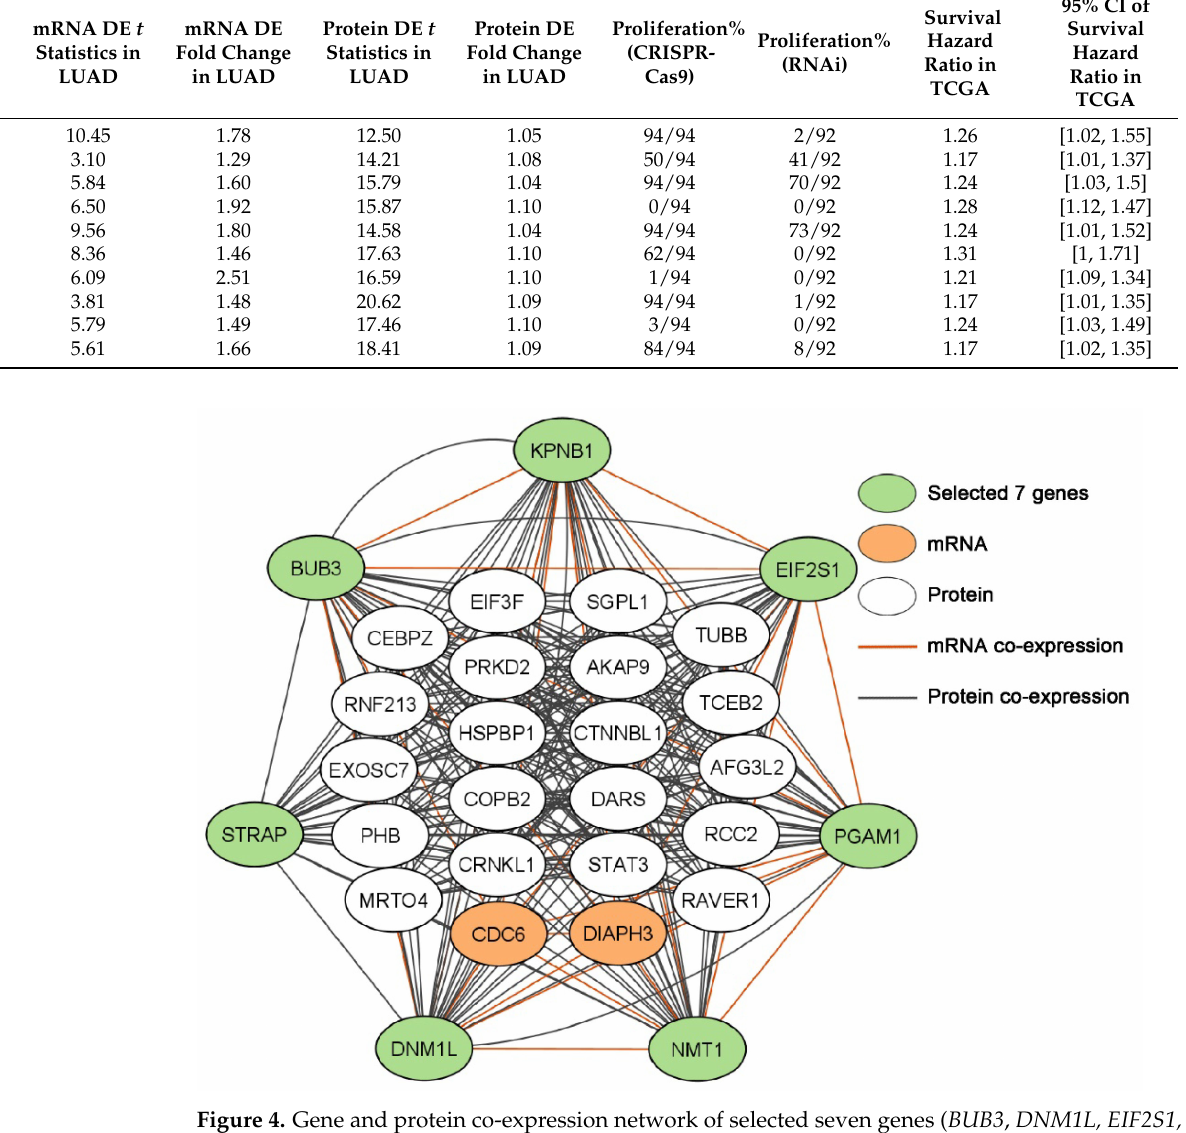
Figure 4. Gene and protein co-expression network of selected seven genes ( BUB3 , DNM1L, EIF2S1, KPNB1, NMT1, PGAM1, and STRAP ) in NSCLC